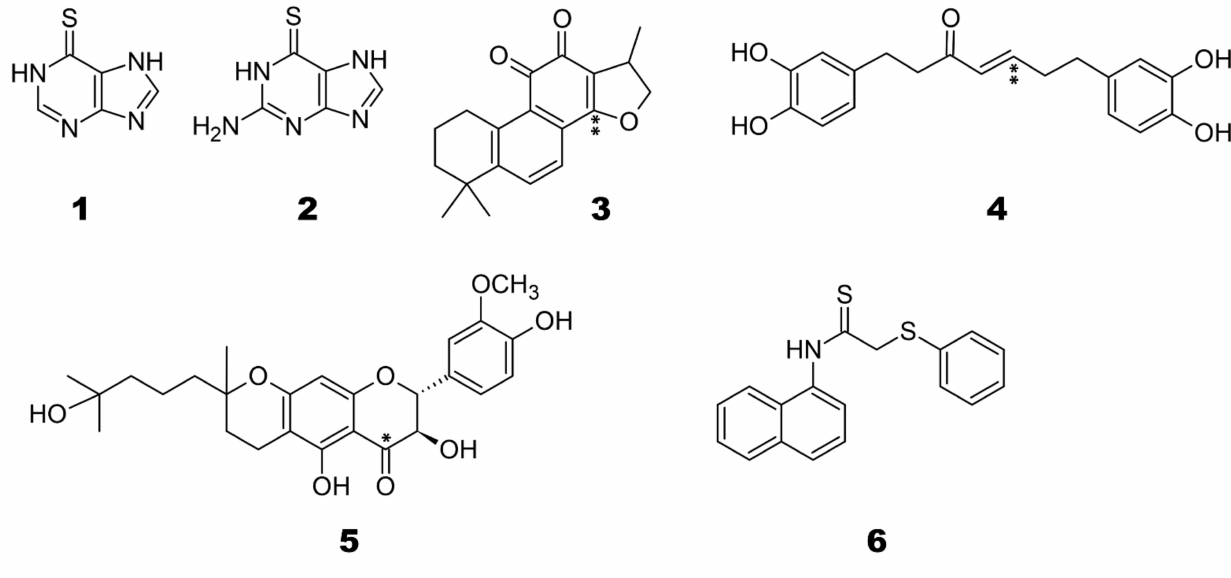
Figure 2. Known SARS-CoV PLpro inhibitors used as candidates during covalent and non-covalent ligand docking against OTUB1/OTUB2 and SARS-CoV-2 PLpro. Studied covalent linkage sites for ‘nucleophilic addition to a double bond’ marked (*) and site which follows ‘Michael addition’ marked (**) in the